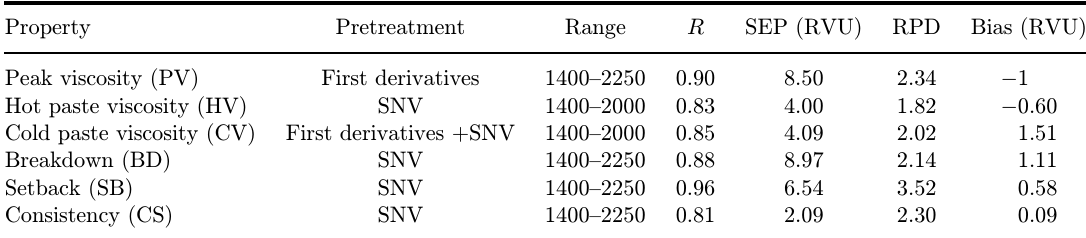
Table 2. PLS models result for predicting pasting properties of paddy rice using di®erence mathematical pre- treatments and wavelength range